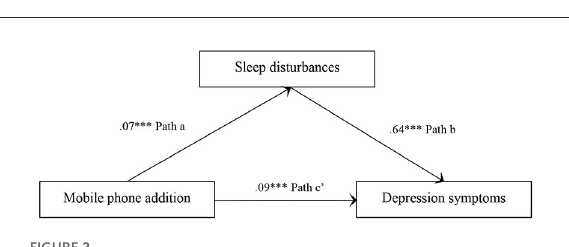
FIGURE2 (Hypothesis 2) Mediation models: effect of mobile phone addition on depression symptoms with the mediation of sleep disturbances *** p <